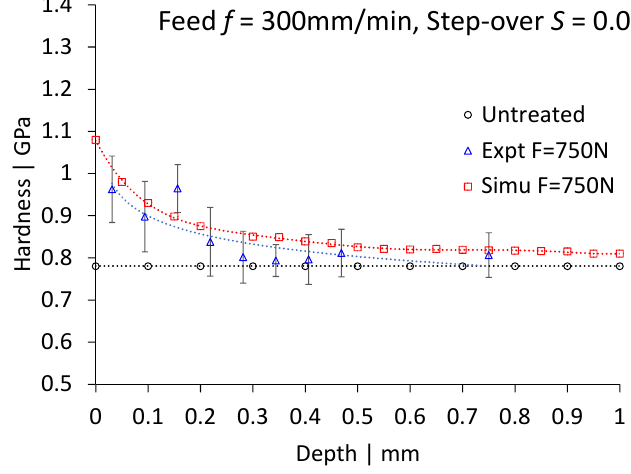
Figure 7. Comparison of experimental and simulated hardness at F = 750 N, f = 300 mm/min, and S = 0.05 mm. The error bar at each data point indicates the standard deviation of the measurement.